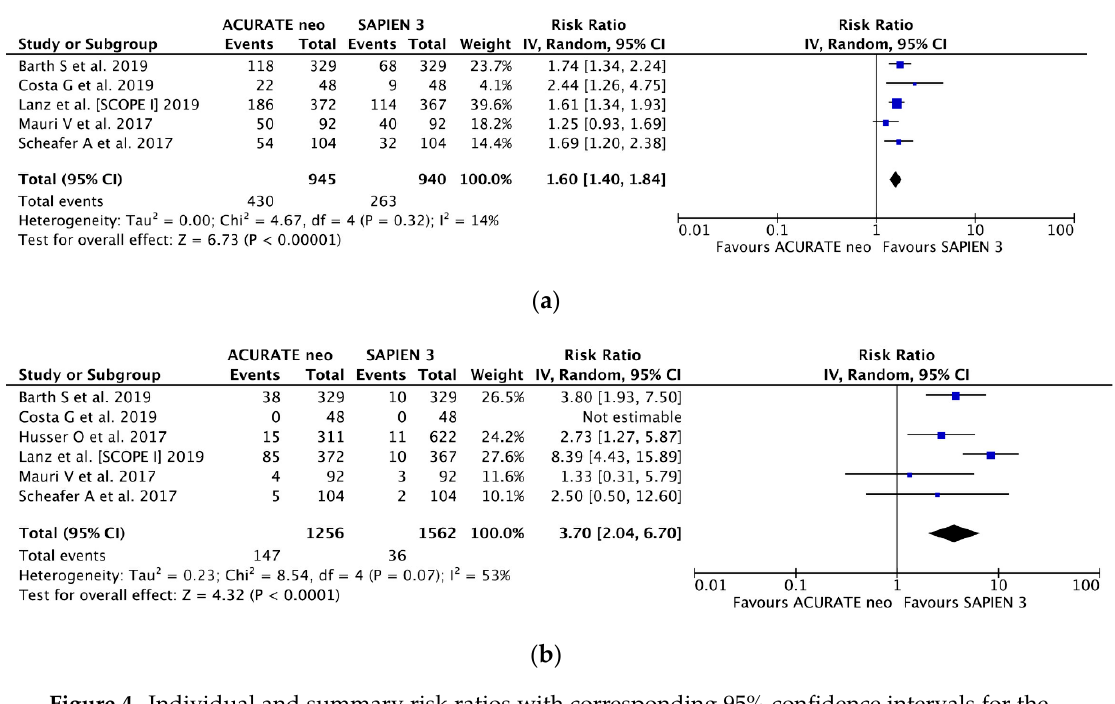
Figure 4. Individual and summary risk ratios with corresponding 95% confidence intervals for the comparison of ACURATE neo vs. SAPIEN 3 in the analysis of functional outcomes: ( a ) mild and ( b ) moderate-to-severe paravalvular leak.